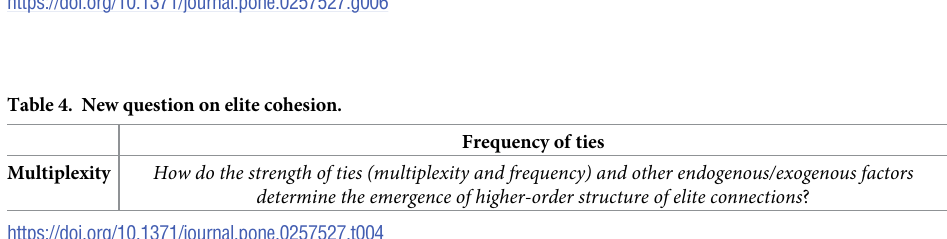
Fig 6. Multiplex digraph of beta community an edge represents three interactions: Status recognized, exchange of useful information and collaboration.